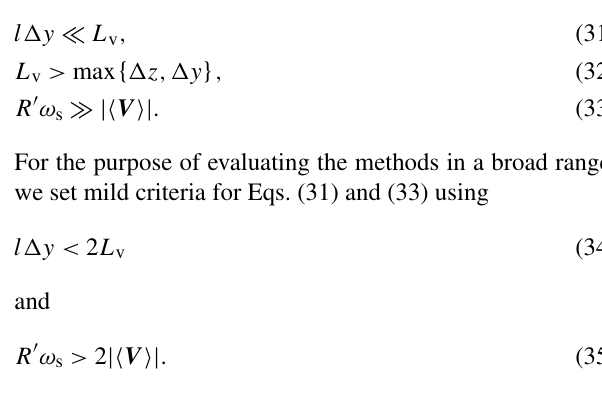
Figure 4. Sketch of the measurement points of a VAD scan in an earth-fixed versus a flow-fixed coordinate system.